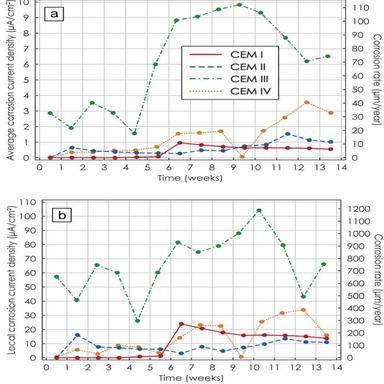
(a) Average corrosion current densities, obtained by applying the total anodic current across all 25 electrodes; (b) highest local corrosion current densities.